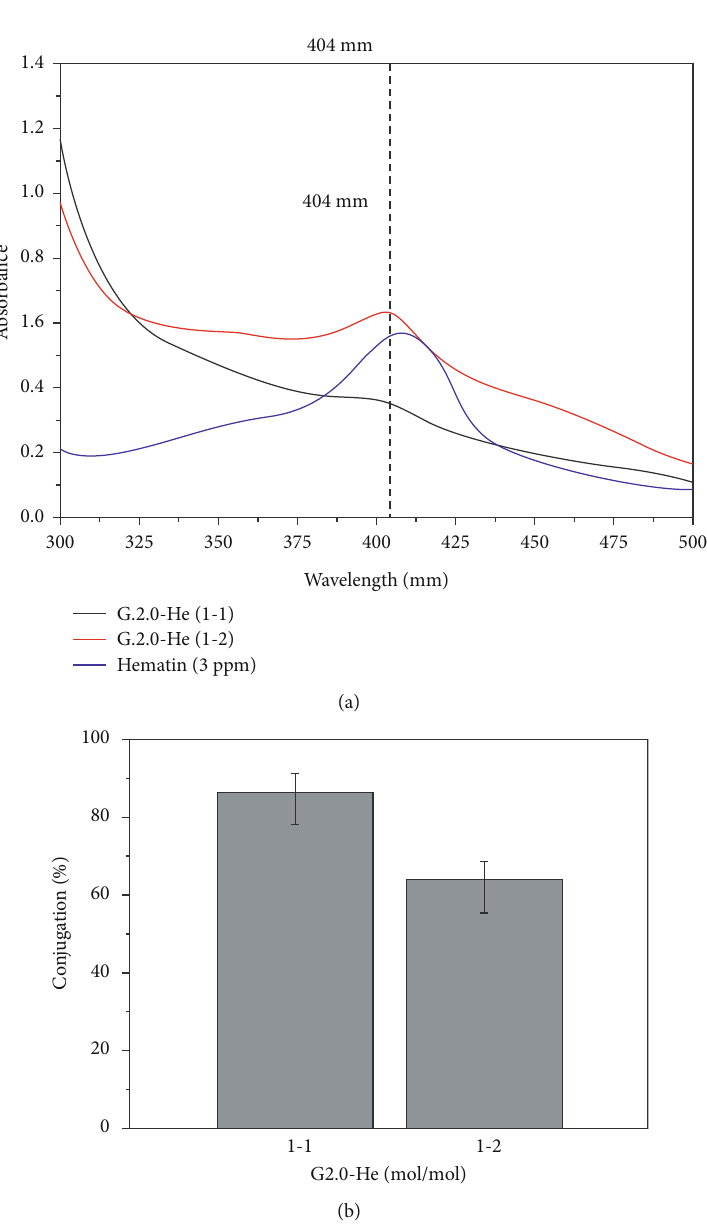
Figure 3: UV-Vis spectra of hematin and G2.0-He (a) and conjugation of G2.0-He